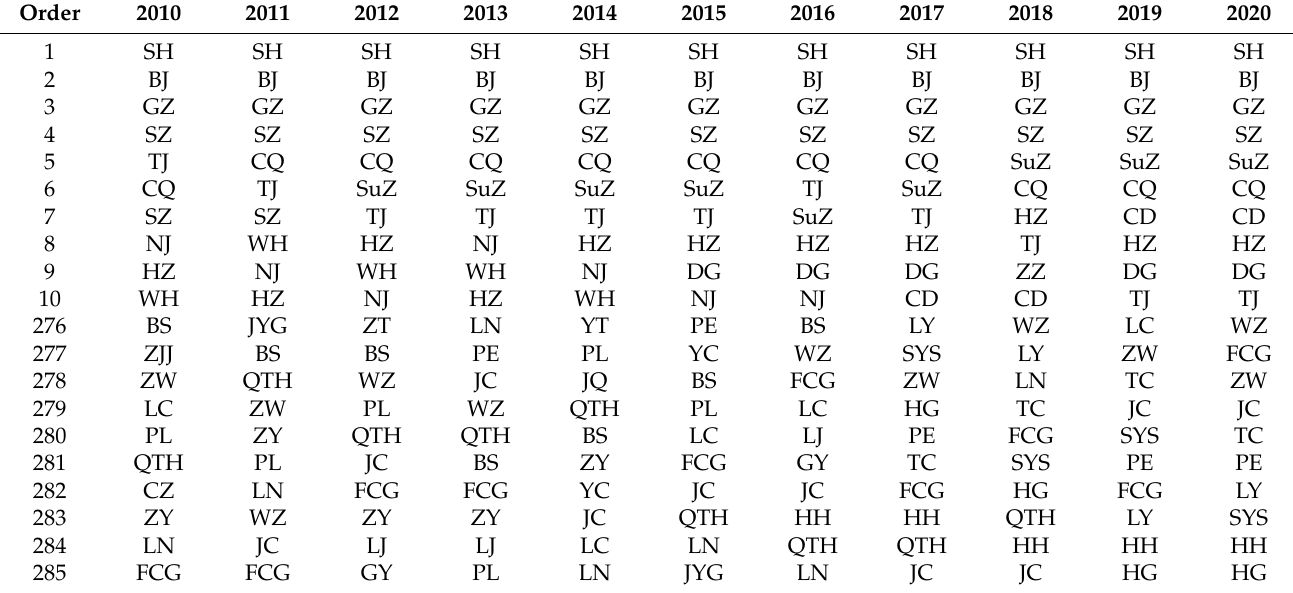
Table 5. Top 10 cities and bottom 10 cities of